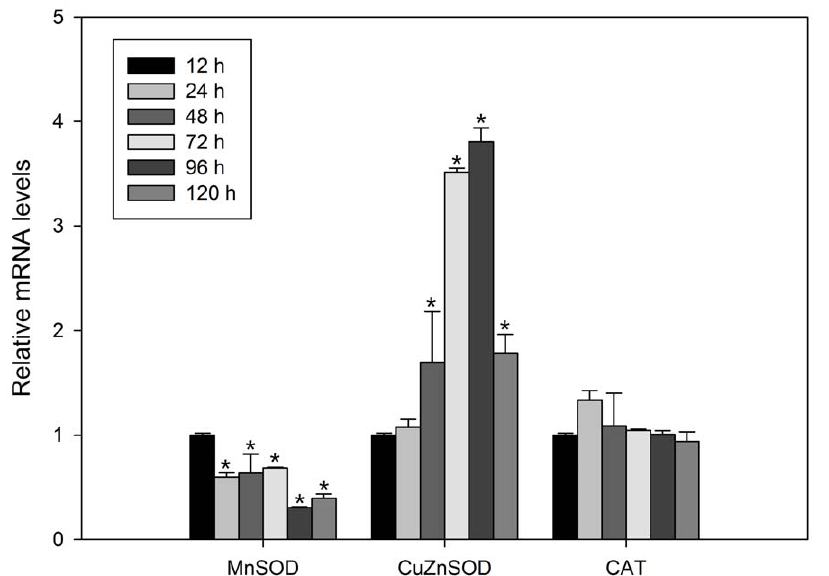
Figure 4. Relative mRNA expression levels of MnSOD, CuZnSOD and CAT from the B.calyciflorus at various ages. Each group contained 100 individuals. Bars represent standard errors. The expression levels were statistically analyzed by one-way ANOVA with the Tukey test. ( * P , 0.05).